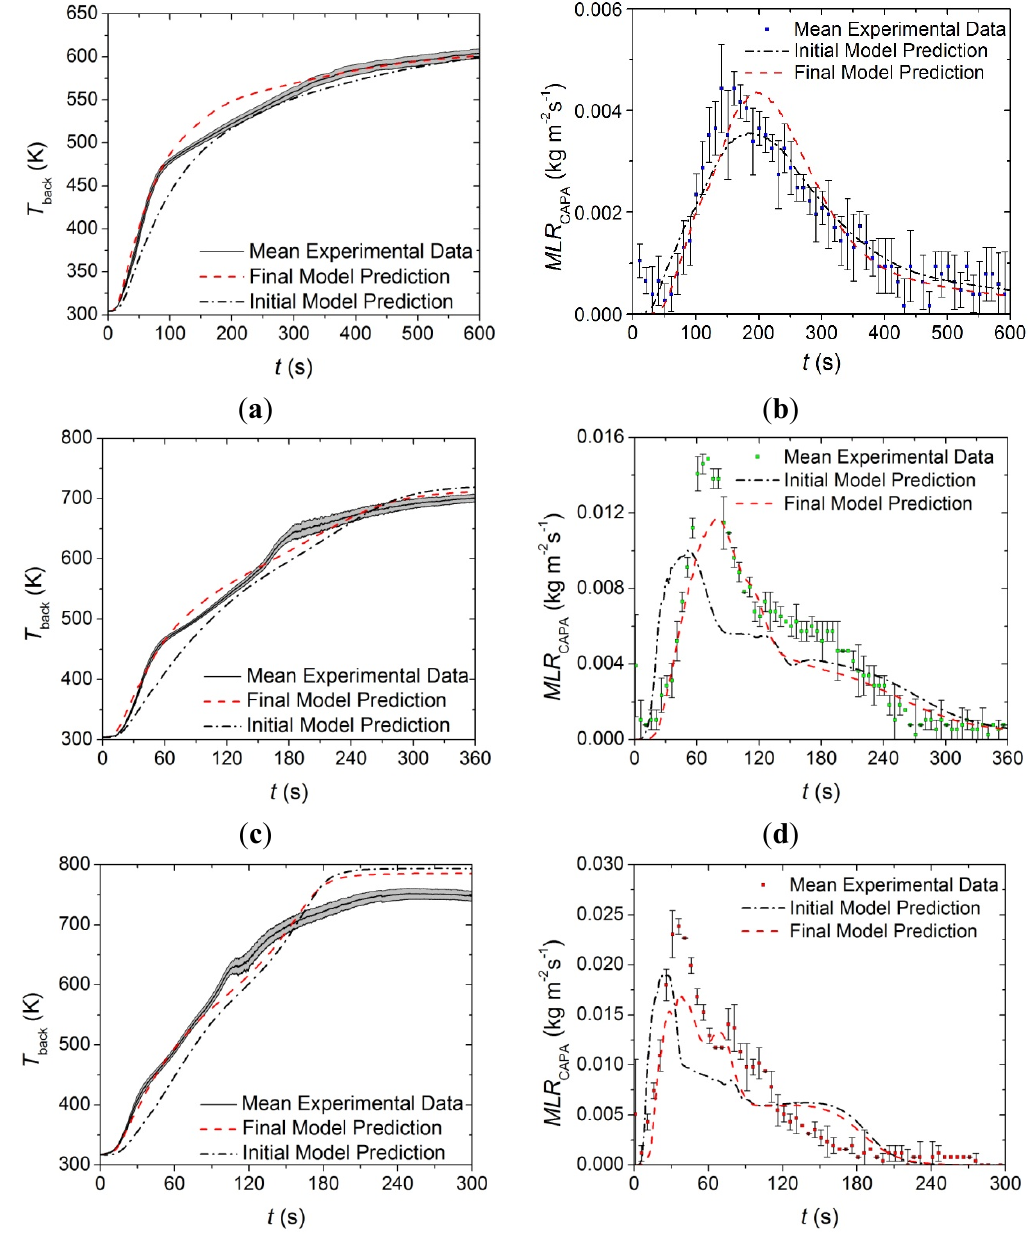
Figure 17. Experimental T back and MLR curve collected in CAPA tests and corresponding model predicted curves for the full carpet composite exposed to radiant fluxes of ( a ) and ( b ) 30 kW·m − 2 , ( c ) and ( d ) 50 kW·m − 2 , and ( e ) and ( f ) 70 kW·m − 2 . The shaded region and error bars correspond to two standard deviations of the mean experimental data.